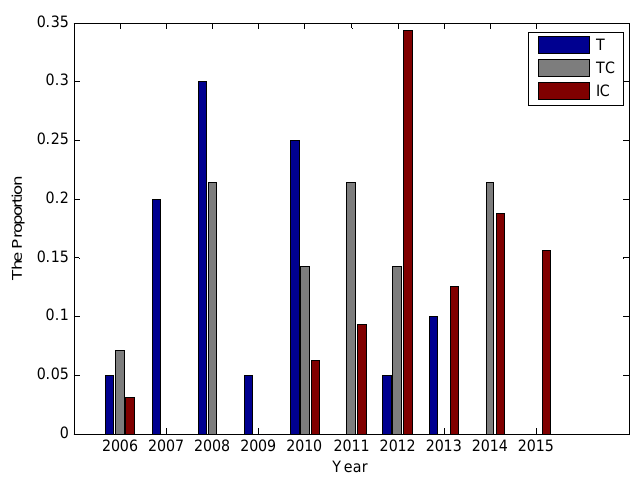
Figure 6. The development trends of UASN routing protocols.